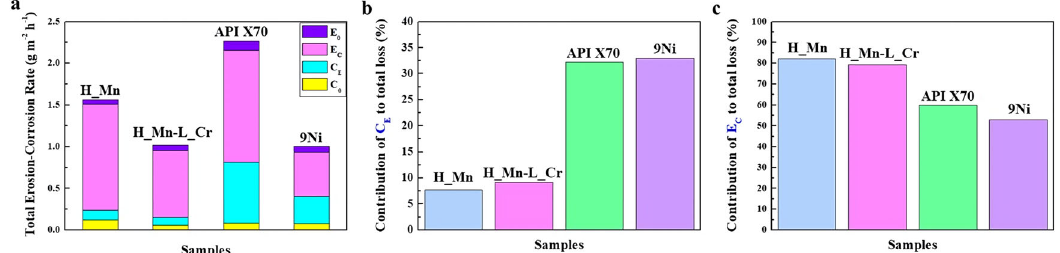
Fig. 5 Erosion – corrosion behaviors of the samples. a Total erosion – corrosion rates. b , c Contribution of C E and E C to total erosion – corrosion rates,